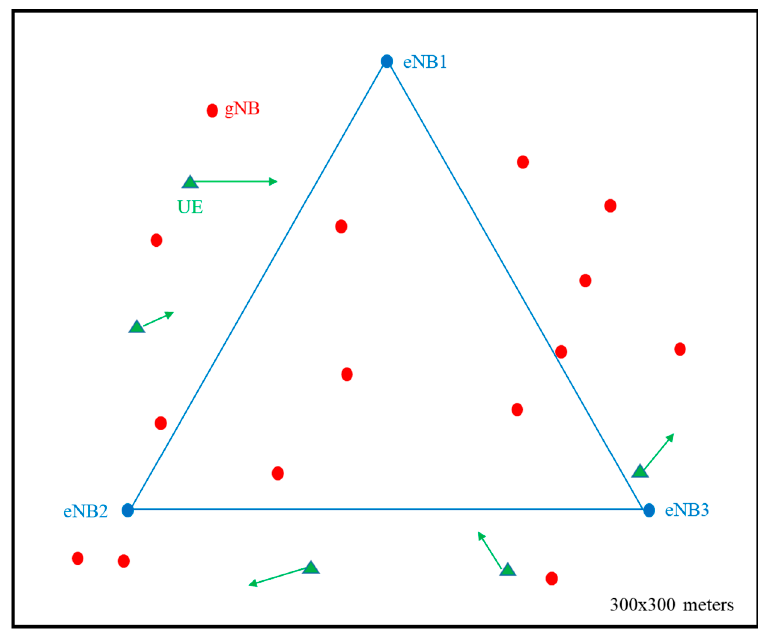
Figure 10. 5G UDN topology used in the simulation. Table 5. Simulation parameter settings.